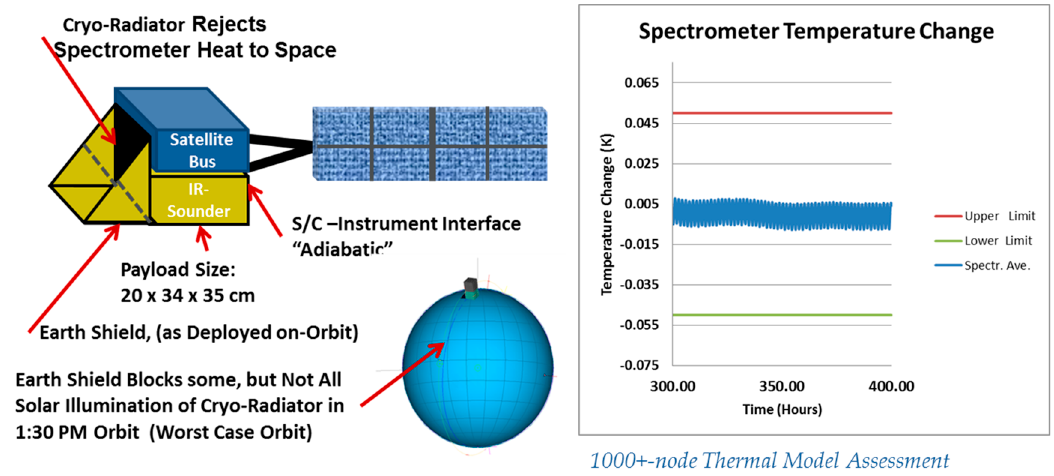
Figure 9. Detailed (1000-node) thermal model analysis of passively cooled spectrometer temperature stability for worst-case sun-synchronous orbit shows substantial margin against requirements for stable IR sounder spectral